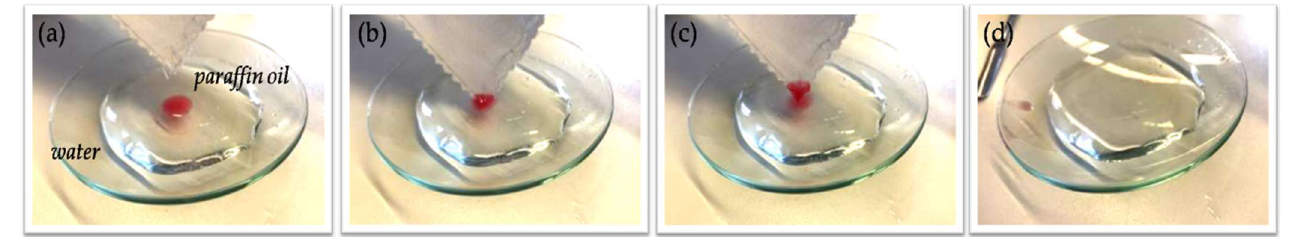
Figure 12. Real-time photos demonstrating the removal of paraffin oil ( a – d ) droplets from water using GC16_ C′16 modified cotton fibers.